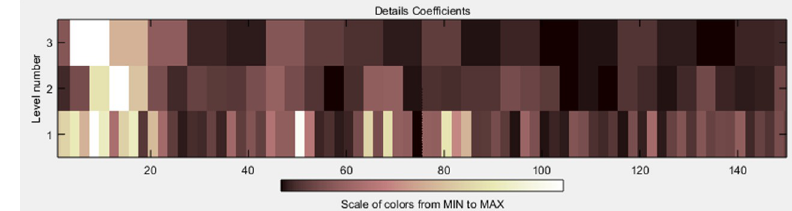
Figure 19. Detail coefficients related to the upward movement. Sensors 2019 , 19 , x FOR PEER REVIEW